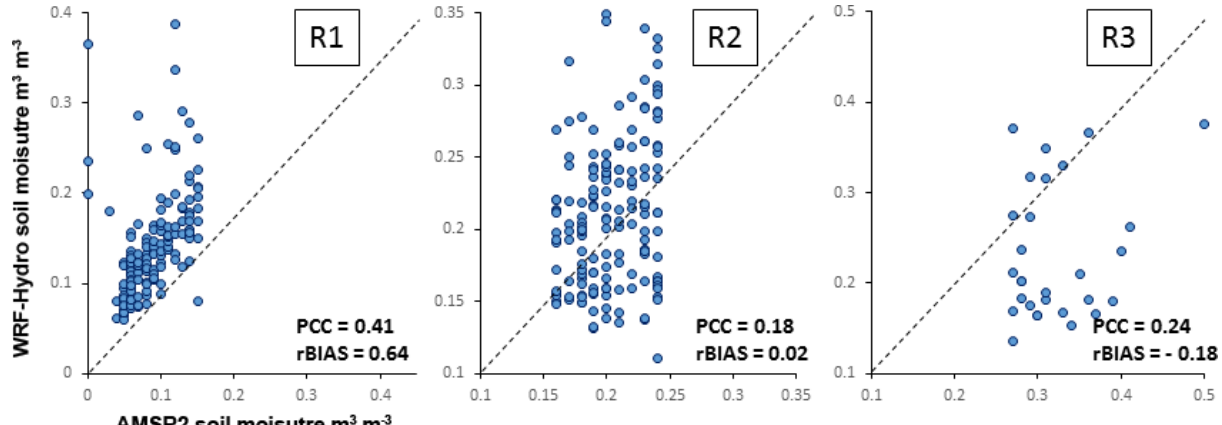
Figure 11. Scatterplots of AMSR2 and WRF-Hydro soil moisture estimates across the UAE.